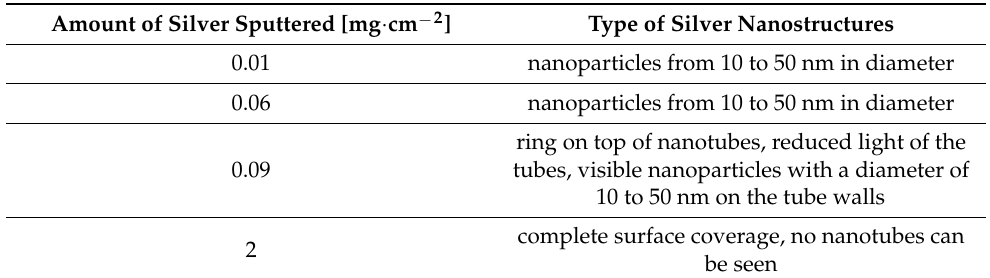
Table 1. The correlation between the amount of silver deposited by sputtering on the layer of TO 2 nanotubes and the structure of the formed metallic layer.